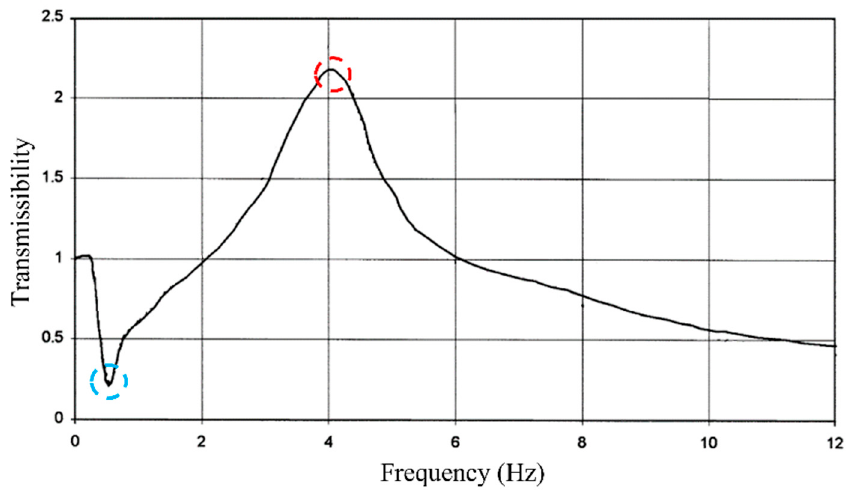
Figure 1. Typical transmissibility curve on conventional train seats (red dot represents the resonant frequency and blue dot represents the antiresonance frequency) (adapted from [42]).